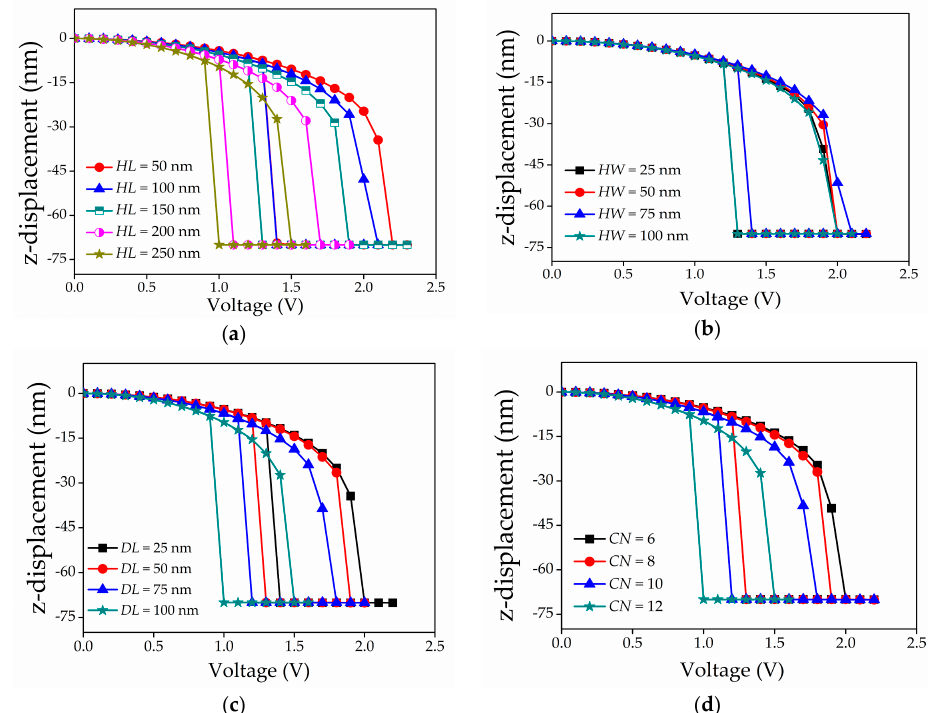
Figure 9. Actuation pull-in voltage characteristics of perforated graphene-based beam NEM switch with variation of: ( a ) hole length; ( b ) hole width; ( c ) distance between two holes; ( d ) number of hole column.